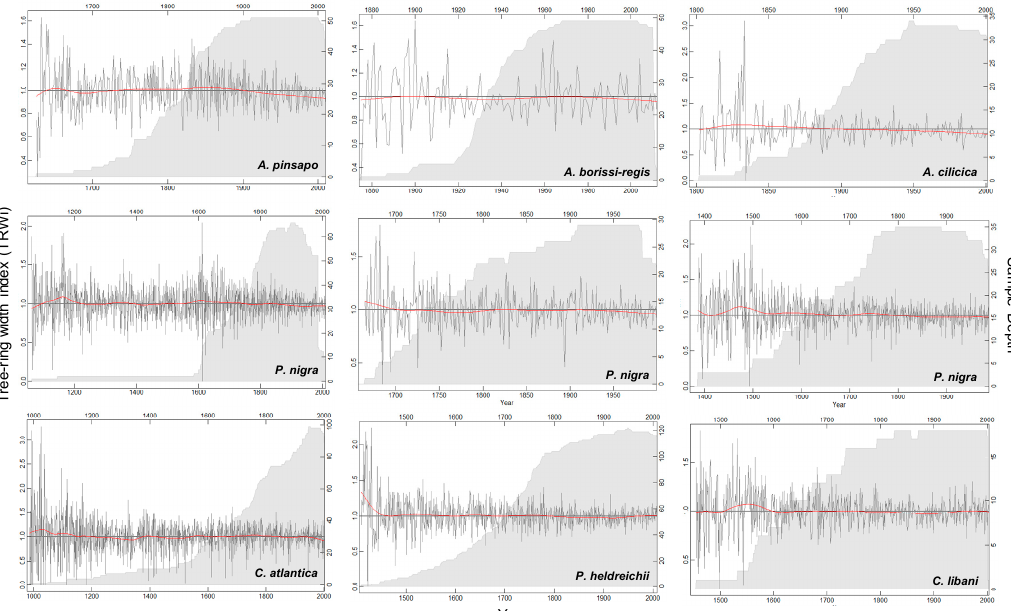
Figure A1. Site chronologies (tree ‐ ring width indices, TRWi; continuous lines) obtained for the studied sites from western (left column), central (central), and eastern (right) regions of the Mediterranean and the number of measured series (grey areas) for each site.